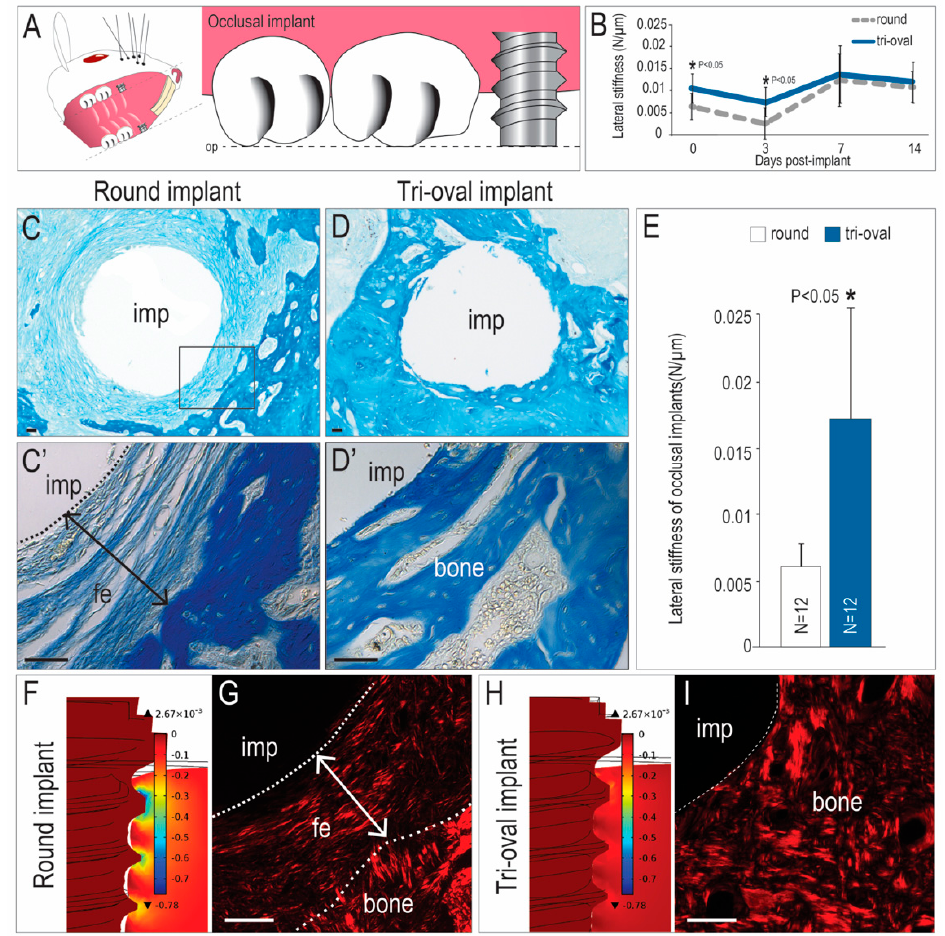
Figure 4. Stability over time as the function of implant geometry. ( A ) Schematic of an occlusal, or functional implant. ( B ) Quantification of lateral stability of sub-occlusal round and tri-oval implants at different timepoints. Aniline blue-stained tissue sections from PID20 through an ( C , C ’) occlusal round implant and ( D , D ’) an occlusal tri-oval implant. ( E ) Quantification of lateral stability of occlusal round and tri-oval implants on PID20. ( F ) In round occlusal implants, FE modeling of peri-implant strain on PID3 and ( G ) picrosirius-red stained tissues from PID20. ( H ) In tri-oval occlusal implants, FE modeling of peri-implant strain on PID3 and ( I ) picrosirius red-stained tissues from PID20. Abbreviations: op, occlusal plane; imp, implant; fe, fibrous encapsulation. Scale bars = 50 µm.